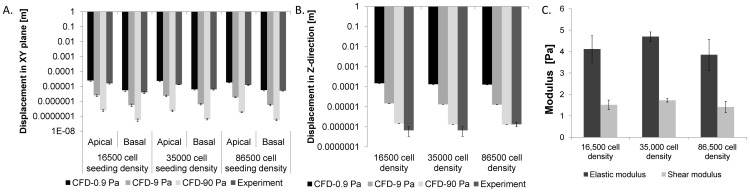
Parametric estimation of the stem cell's mechanical properties.Displacements in the XY plane (A) and Z direction (B) were predicted computationally, using values varied parametrically (by orders of magnitude) about a known measured value for osteoblasts (900 Pa). By comparing experimentally measured displacements with displacements predicted for model cells with estimated moduli, a best estimate for the elastic and shear moduli of the model stem cell line could be made. The vertical axes are depicted in a logarithmic scale. C. Through linear interpolation, parametric estimates were made for elastic and shear modulus of the model stem cell, for flow generating a target shear of 1 dyn/cm2 and for three seeding conditions (different densities). Error bars show standard errors (n = 3).